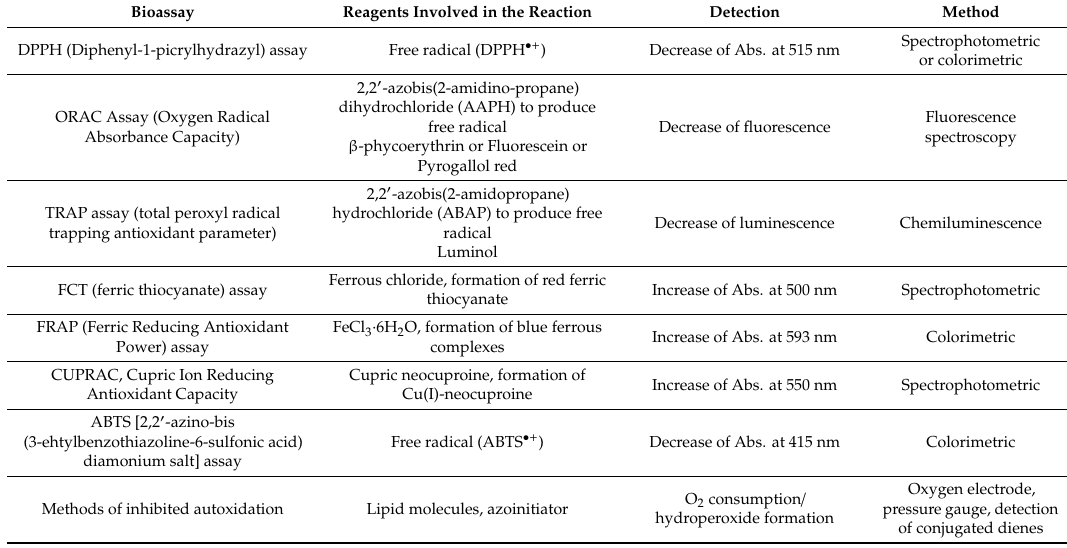
Table 1. Commonly used methods for measurement in vitro of antioxidant activity Bioassay Reagents Involved in the Reaction Detection Method DPPH (Diphenyl-1-picrylhydrazyl)